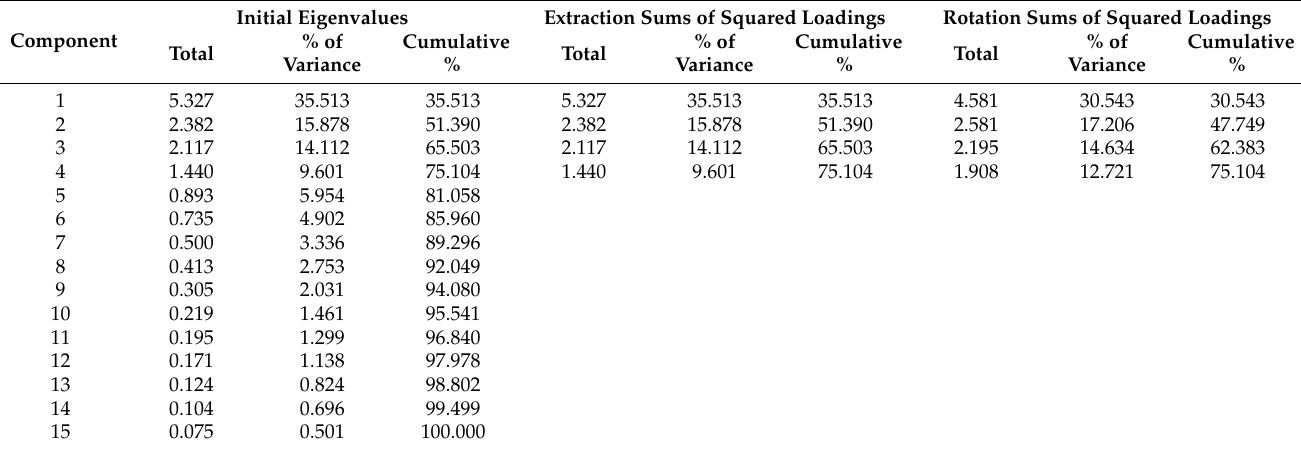
Table 5. Total Variance Explained by